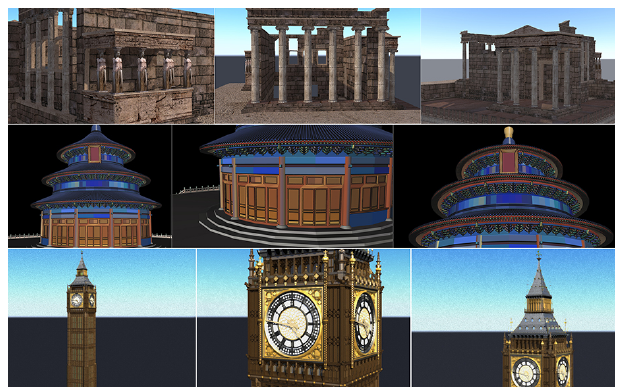
Figure 2. Three image sets (blocks) (9 rendered shots) used in the study. Erechtheion temple rendered using PR (top); the Temple of Heaven rendered using NPR- TI (middle); the clock tower of the palace of Westminster (Big Ben) rendered using NPR-W